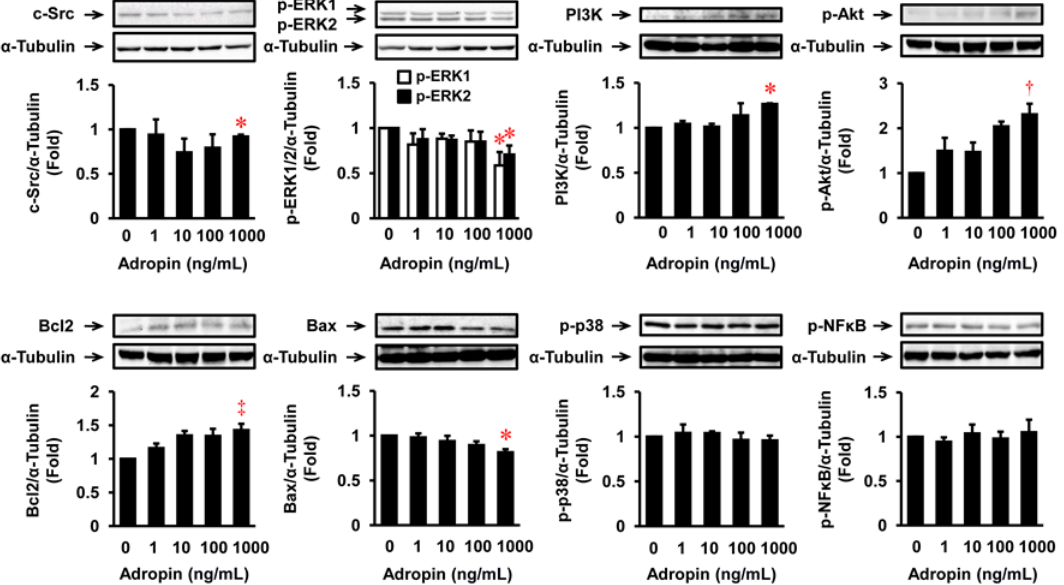
Figure 5. Effects of adropin on intracellular signal transduction in HASMCs. HASMCs were incubated for 24 h in 5% FBS-SmGM-2 with the indicated concentrations of adropin. The effects of adropin on intracellular signals were assessed by immunoblots. Representative data showing protein expression or phosphorylation (upper panels) with densitometry following normalization relative to α -tubulin (lower panels, n = 3–4). * p < 0.05, † p < 0.001, ‡ p < 0.005 vs. 0 ng/mL of adropin.